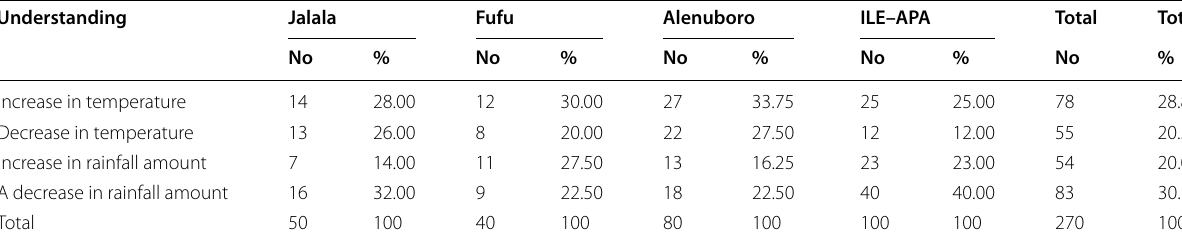
Table 3 Rural women’s understanding of climate change Understanding